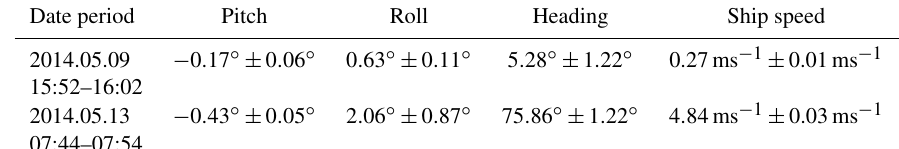
Table 4. Ship motion parameters during anchored (first line) and cruising (second line) observations, respectively.